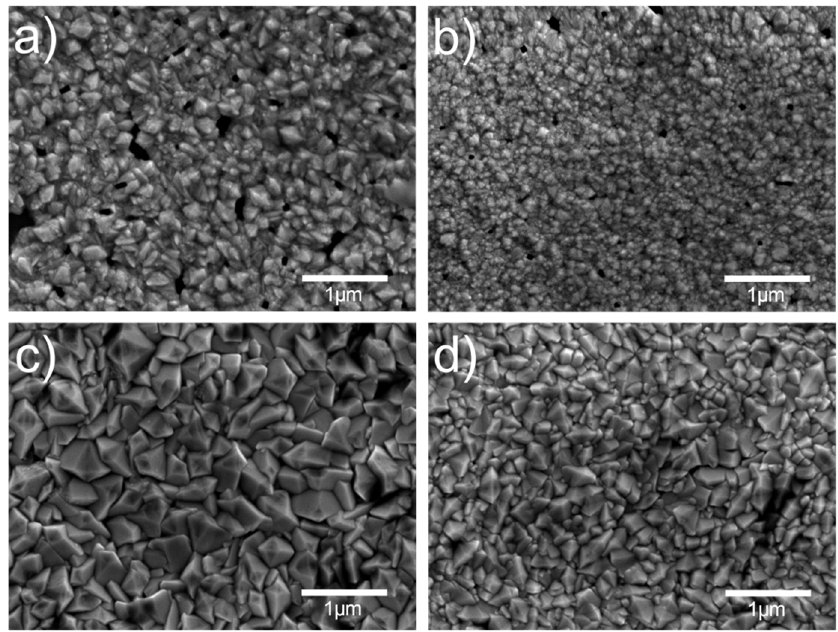
Figure 1. SEM images of SnO 2 samples: ( a ) S-590, ( b ) S-610, ( c ) B-590 and ( d ) B-610. Average grain size calculated using Equation (1) are: 104 nm (S-590), 84 nm (S-610), 190 nm (B-590), 99 nm (B-610).